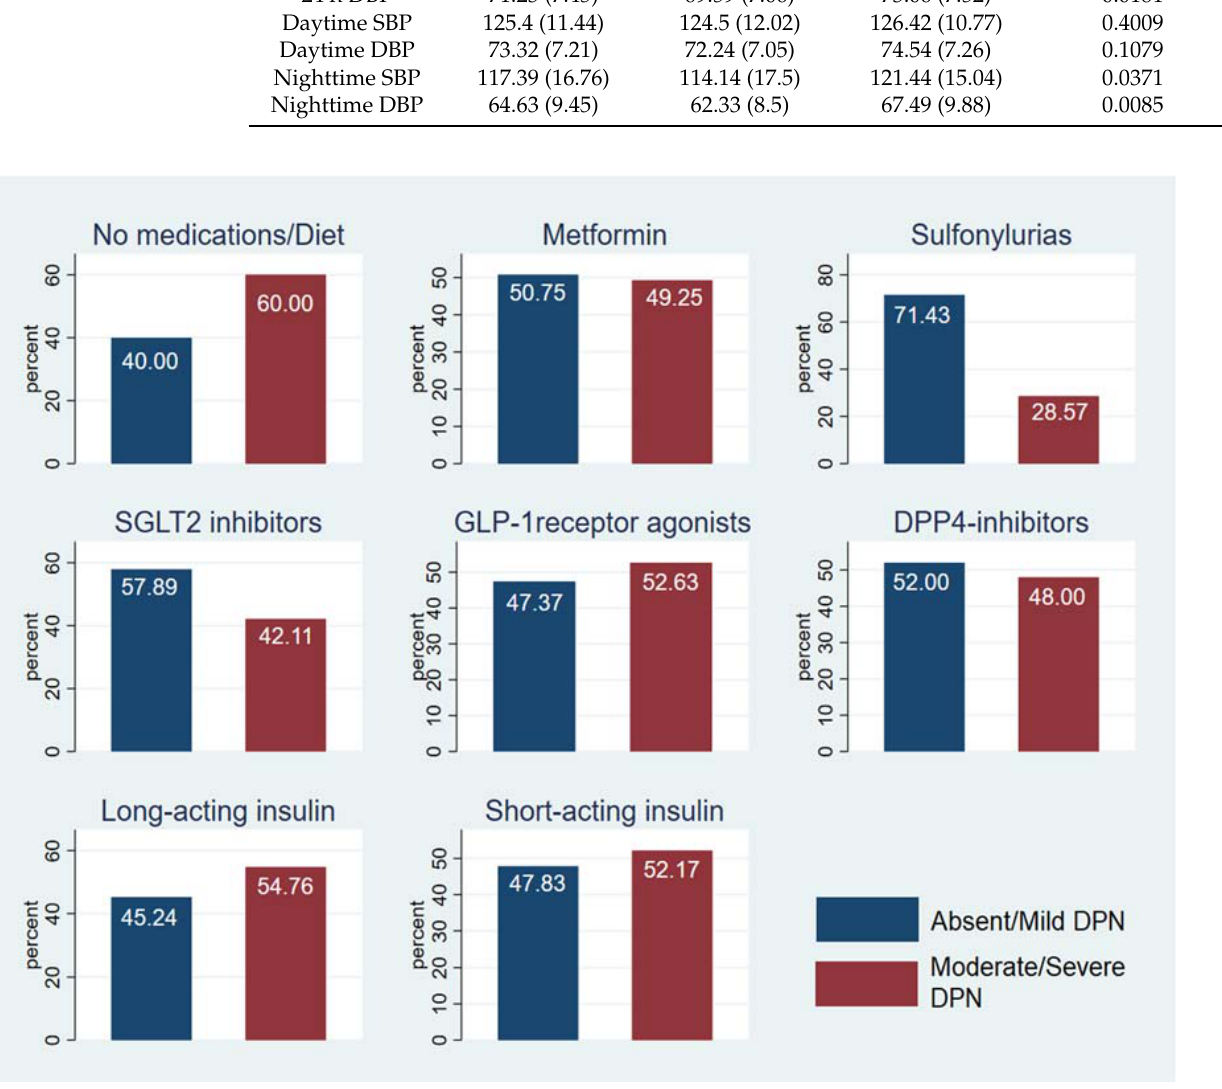
Figure 1. Schematic association of antidiabetic medication and DPN status